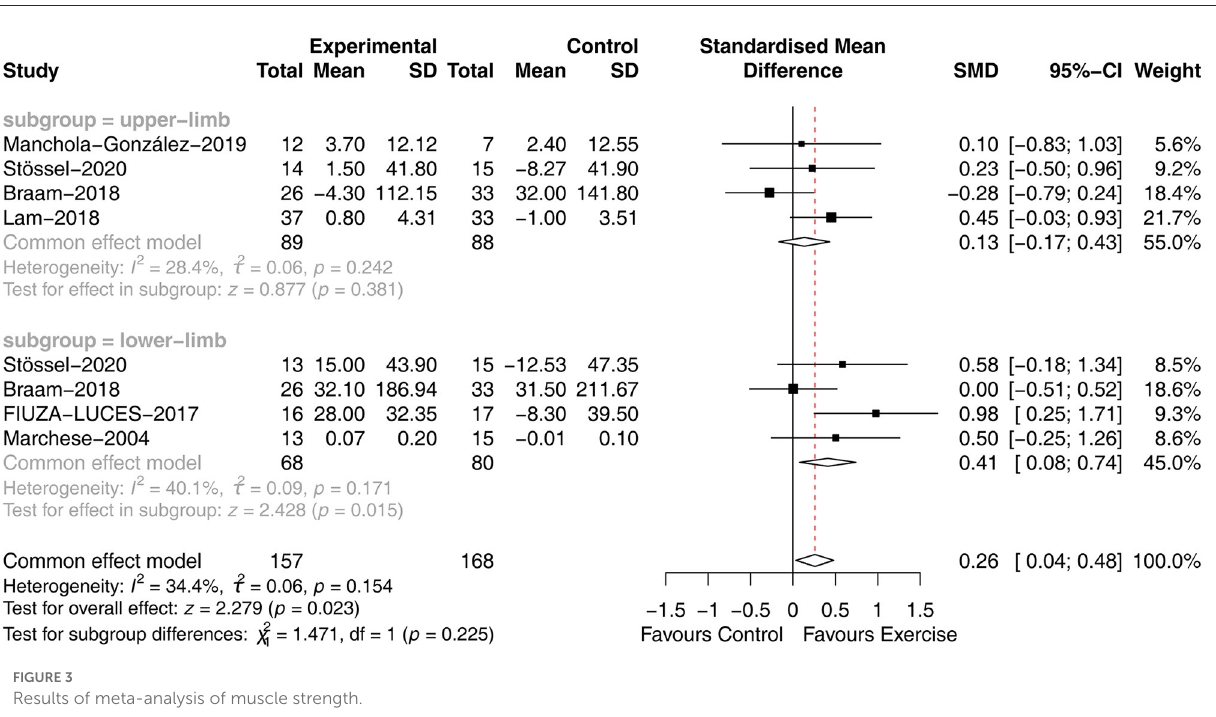
the SMD was selected for effect size pooling because of the different physical activity measurement tools used. Heterogeneity between studies was significant ( P = 0.006, I 2 = 72.4%), and a random effects model was used for analysis, revealing a statistically significant difference in physical activity between the exercise and usual care groups [SMD = 0.57, 95% CI (0.03, 1.1), P =